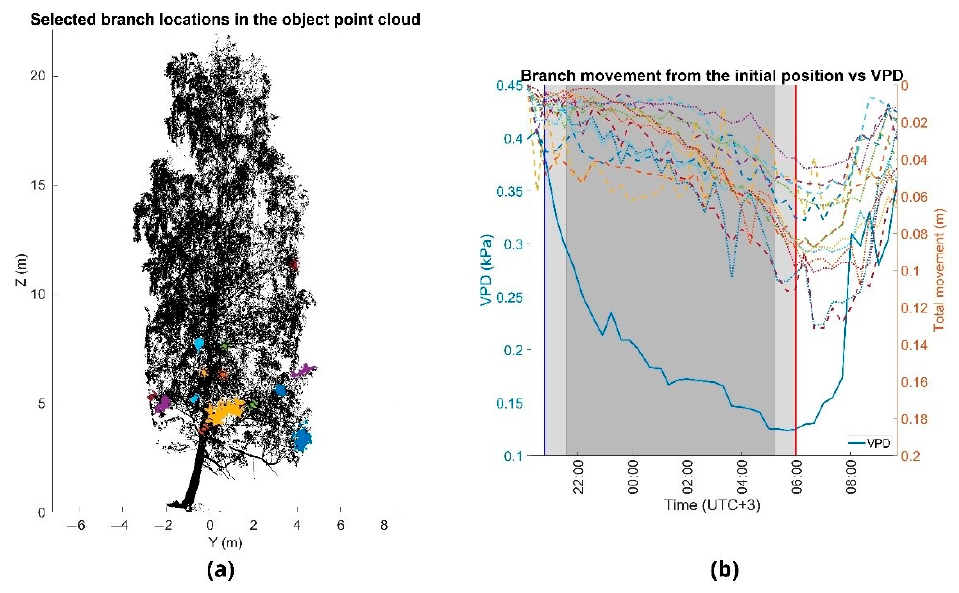
Figure 5. ( a ) Point cloud of the silver birch ( Betula pendula Roth .) in August 2016. ( b ) Overnight branch movement during monitoring period. Branch movements are marked with the dashed lines and the vapor ‐ pressure deficit (VPD) with the solid blue line. The times of sunset and sunrise are marked with the blue and red vertical lines, at 8:40 p.m. and 6:00 a.m., respectively. Civil twilight time is marked with the light gray area, and time of nautical and astronomical twilight with the dark gray area.